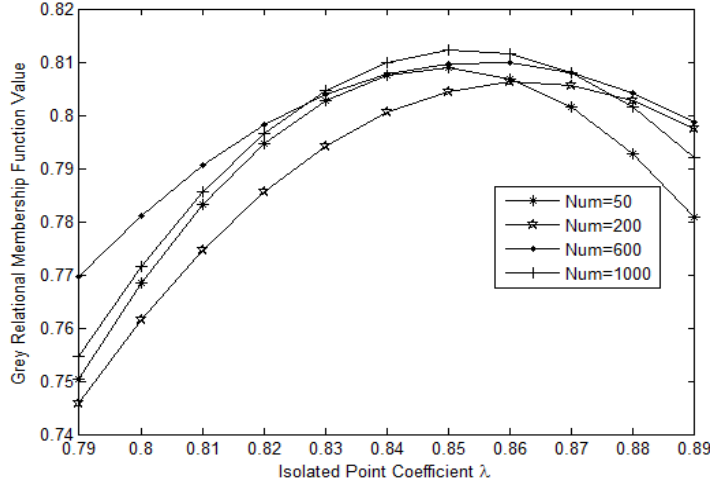
Figure 5. Grey relational membership function as a function of λ .